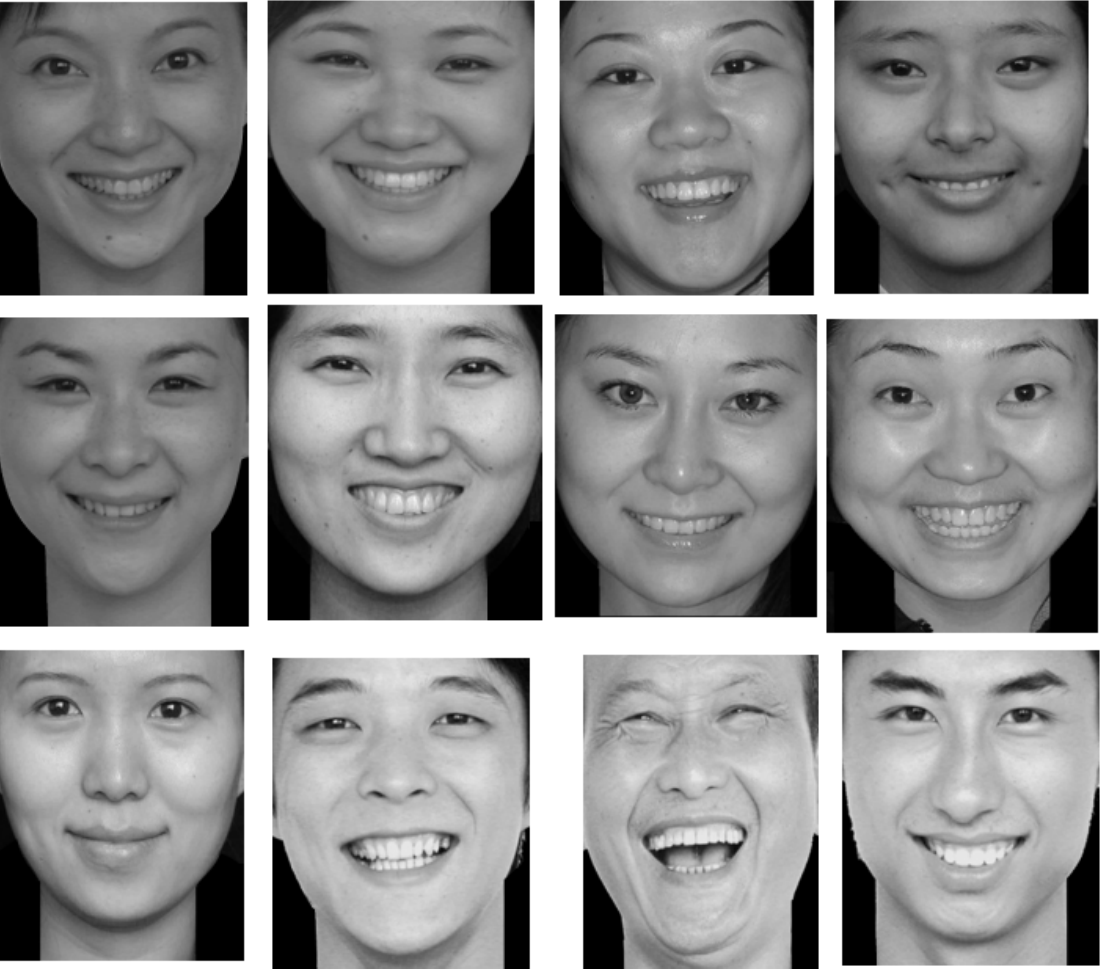
Figure 1. Twelve pictures of positive expressions. The SC-IAT program consists of five blocks, including three practice blocks and two task blocks (see Table 1). When the input is numbered with an odd number, the third trial is the compatible task, and the fifth trial is the incompatible task. When the input is numbered with an even number, the tasks of these trails are assigned in the opposite way. D score of implicit attitudes followed the improved scoring algorithm put forward by Greenwald et al. [24] The delayed trial and error trial of more than 10,000 ms were deleted. D score is the value which can be computed as follows: (1) average response time of incompatible test subtracts average response time of compatible test; (2) the resulting difference from the previous step is divided by the standard deviation of reaction time of all correct